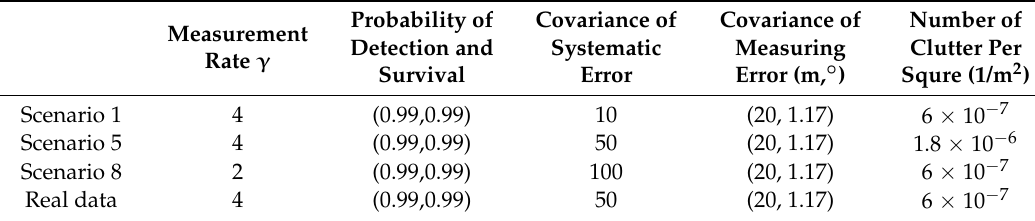
Table 3. Parameter values used for simulations and real data.